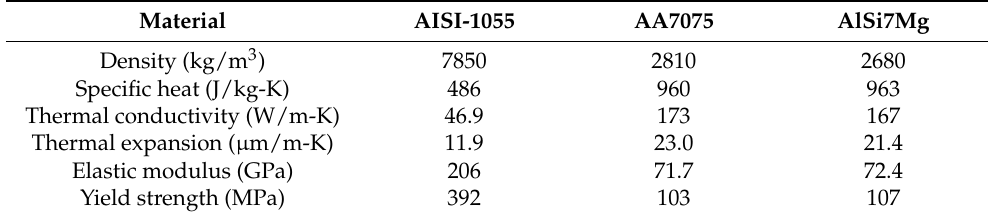
Table 1. Thermal and mechanical properties of used materials.